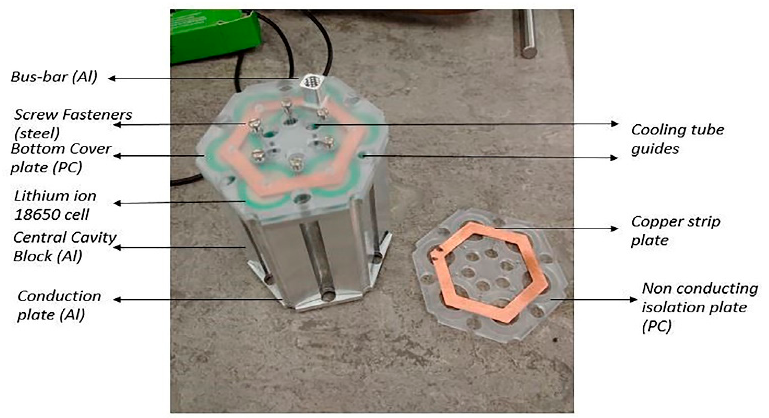
Figure 6. ( a ) Tetrahedral meshing for the module section and ( b ) steady-state thermal analysis simulation result for 2C wet discharge.